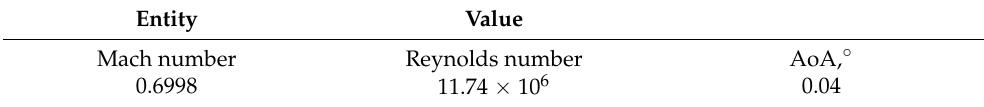
Table A2. ONERA M6 wind-tunnel-testing flow conditions—Test